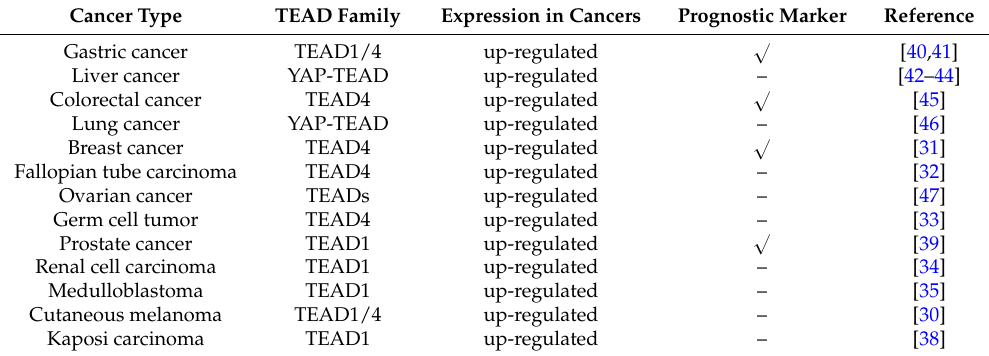
Table 1. Summary of TEAD family expression in malignancies. In nearly all the cancer types, the expression of TEADs are up-regulated, suggesting a tumor-promoting role of TEADs. In gastric, colorectal, breast and prostate cancer, the upregulation of TEADs correlates with poor survival in